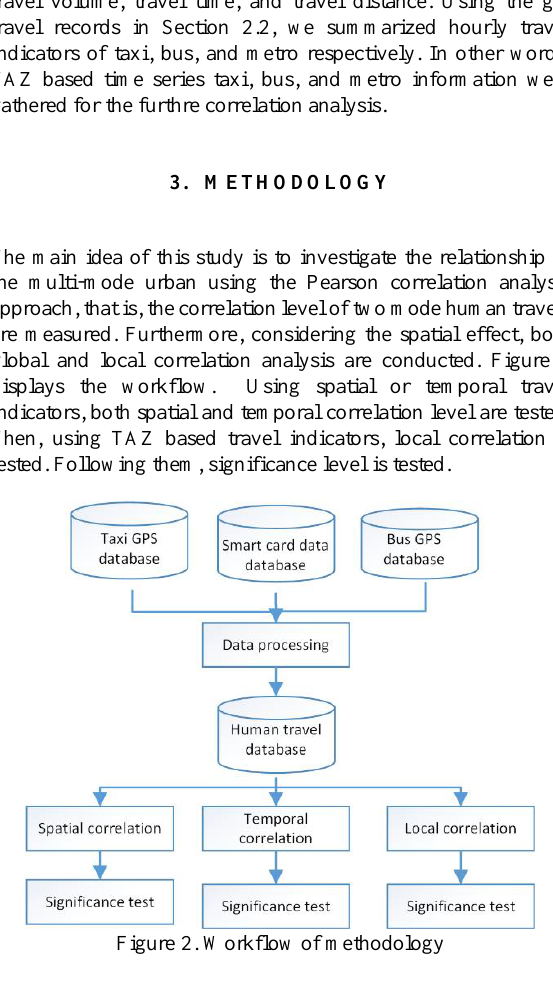
Figure 1. Study area